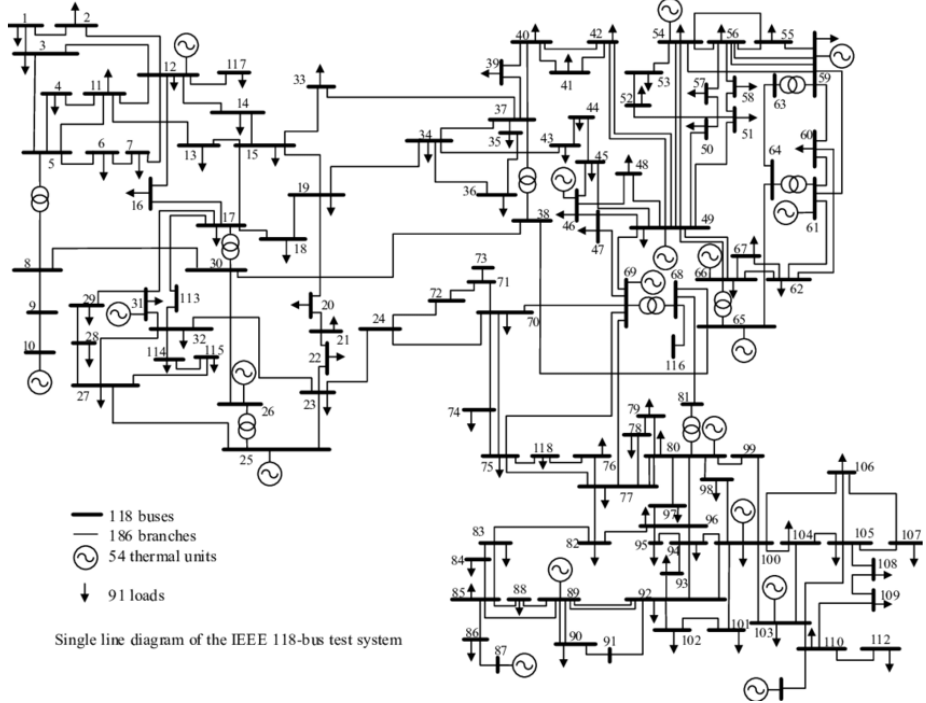
Figure 3. The single line diagram of IEEE 118-node system.